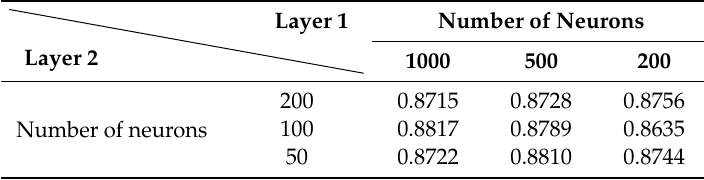
Table 9. Validation accuracy of di ff erent two-layer compositions, using a ResNet-50 extractor.